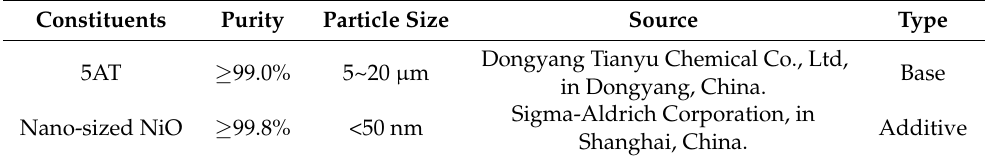
Table 1. Information on the ingredients of propellant